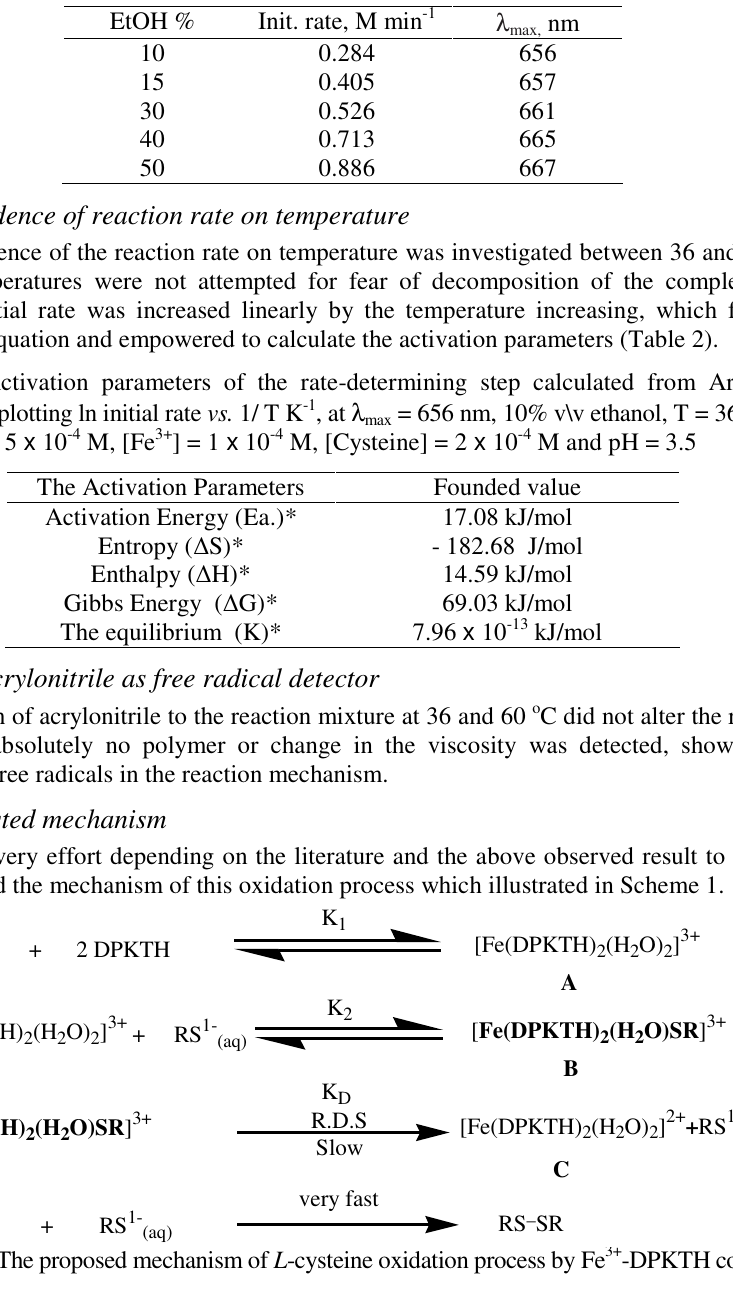
) of [Fe(DPKTH) ] 2+ max 2